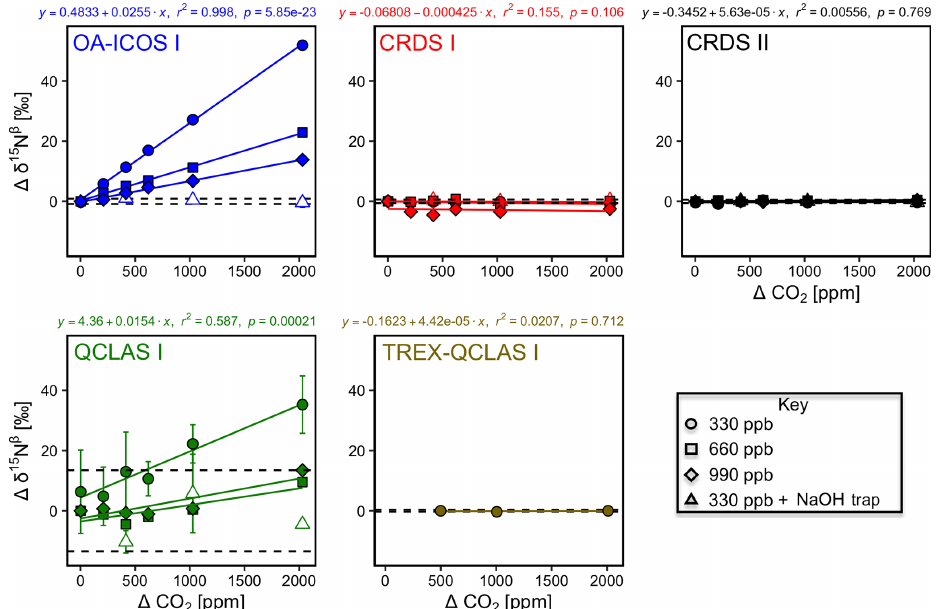
Figure 7. Deviations of the measured [ N 2 O ] , δ 15 N α , δ 15 N β and δ 18 O values according to (cid:49) CO 2 (ppm) at different N 2 O mole fractions (330, 660 and 990ppb) for the OA-ICOS I (blue), CRDS I (red), CRDS II (black), QCLAS I (green) and TREX-QCLAS I (brown). The remaining plots for [ N 2 O ] , δ 15 N α and δ 18 O are provided in Sect. S4 (Fig. S4-6). The standard deviation of the Anchor gas ( ± 1 σ ) is indicated by dashed lines. Data points represent the mean and standard deviation (1 σ ) of triplicate measurements. Dependencies are best described by linear fits, which are indicated by solid lines. Individual equations, coefficients of determination ( r 2 ) and p values are indicated above each plot for the 330ppb N 2 O data only.